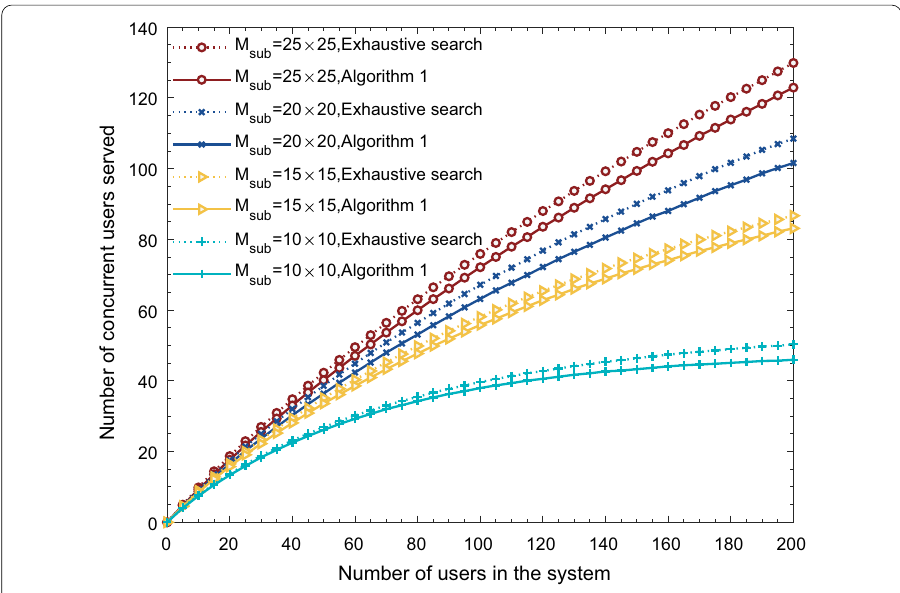
Fig. 2 Comparison of the number of simultaneous users served in the